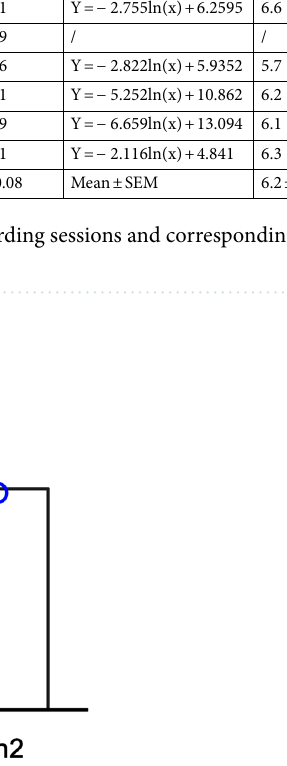
Figure 4. p-ERG acuity in the experimental animals during the two recording sessions. The electrical signals recorded during the first session significantly increased in the second one suggesting a developmental maturation of the spatial resolution. ** p = 0.0032; paired t -test.